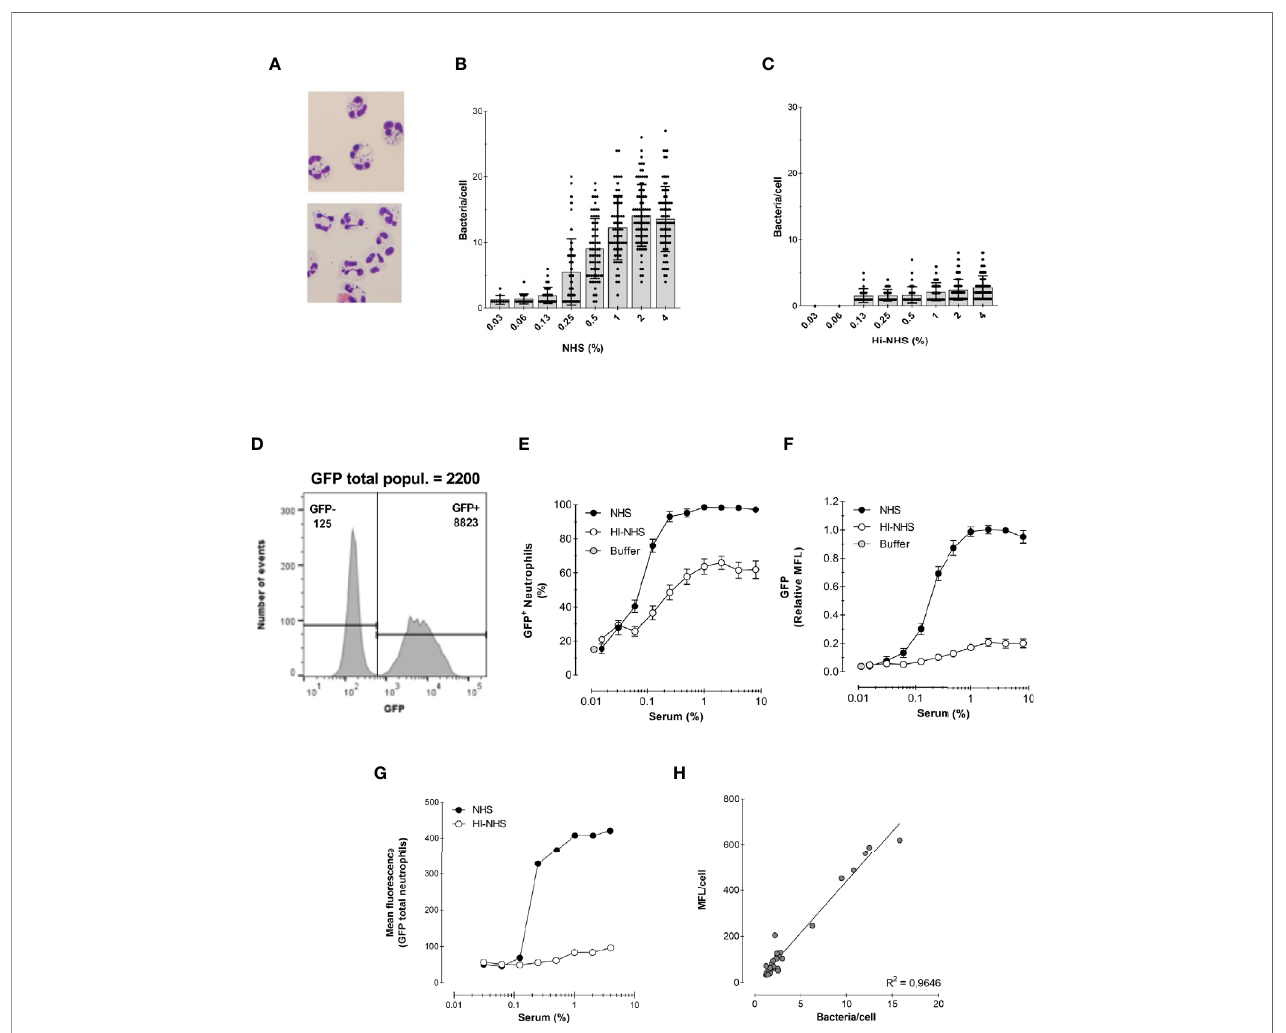
FIGURE 3 | Correlation between microscopy and fl ow cytometry. (A) Example of cytospin preparation after phagocytosis for 15 min with 1% NHS (top) and 1% HI-NHS (bottom). (B, C) Counting bacteria per neutrophil on cytospin preparations after phagocytosis with NHS (B) and HI-NHS (C) . Individual counts and means ± SD (n=25 – 100) for only neutrophils with bacteria. (D) Representative histogram to show GFP − and GFP+ population and their corresponding MFL value versus their total MFL. (E, F) Flow cytometry analysis of phagocytosis with NHS and HI-NHS shown as % GFP+ neutrophils (E) and relative MFL to 8% NHS (F) for total neutrophil population. (G, H) Representative fi gure for MFL of only the GFP+ neutrophil population (G) and correlation of that with microscopic counts per cell (H) for n=2